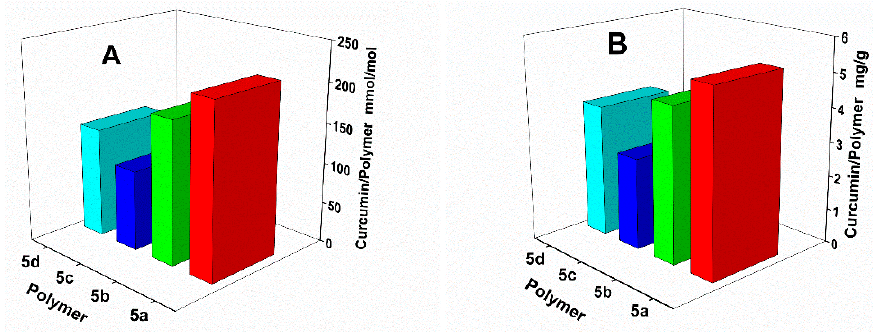
Figure 4. Quantification of curcumin encapsulated by polymers: ( A ) transport capacity; ( B ) transport efficiency.